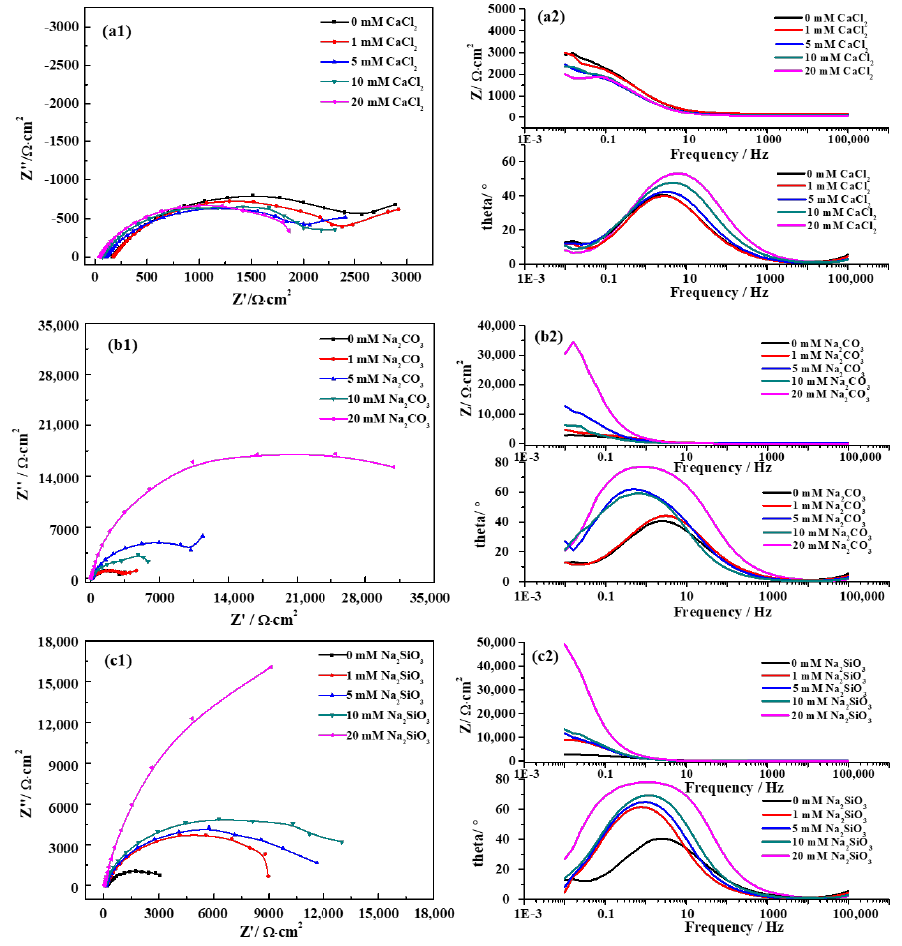
Figure 3. EIS Nyquist (1) and Bode (2) spectra of pure iron in different simulated groundwaters at 40 °C. ( a ) SG + CaCl 2 ; ( b ) SG + Na 2 CO 3 ; ( c ) SG + Na 2 SiO 3 . Table 4. Electrochemical parameters of equivalent circuit of electrochemical impedance spectroscopy